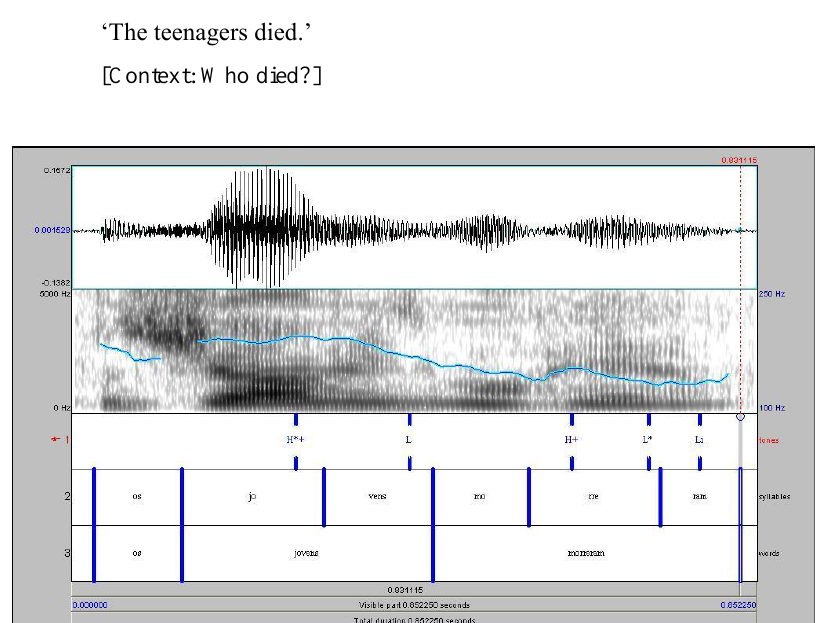
Figure 4. F 0 contour of the subject-focus sentence Os jovens morreram ‘The teenagers died’ produced by F in the context of narrow-focus on the